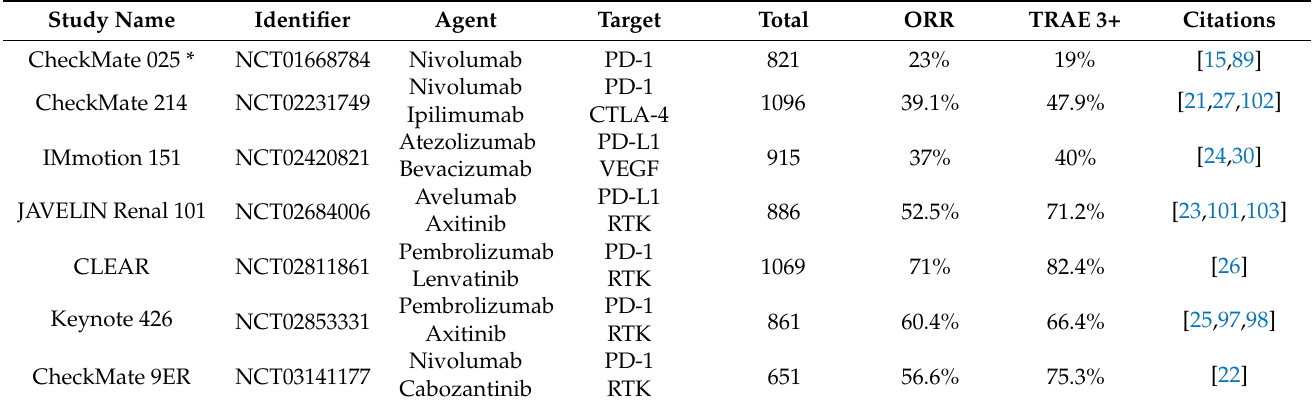
Table 1. Updated phase III clinical trials investigating immunotherapies for advanced